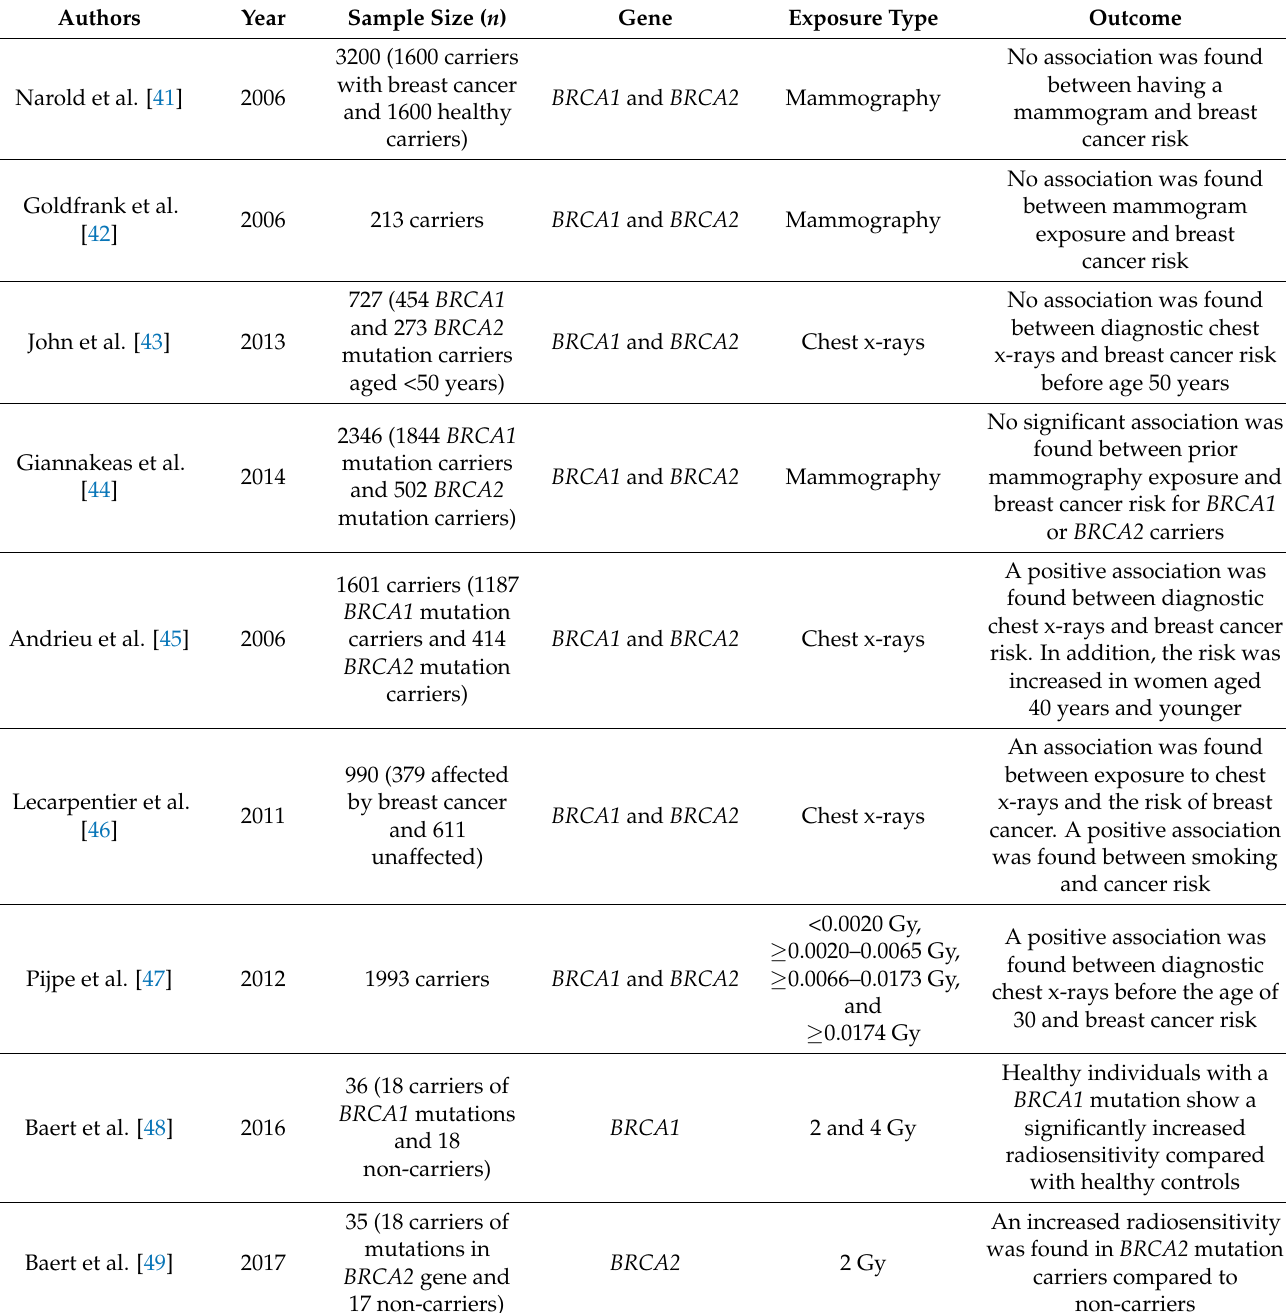
Table 1. Summary of studies carried out that evaluated the risks associated with exposure to ionizing radiation, associated with diagnostic exams, in carriers of mutations in the BRCA1 and BRCA2